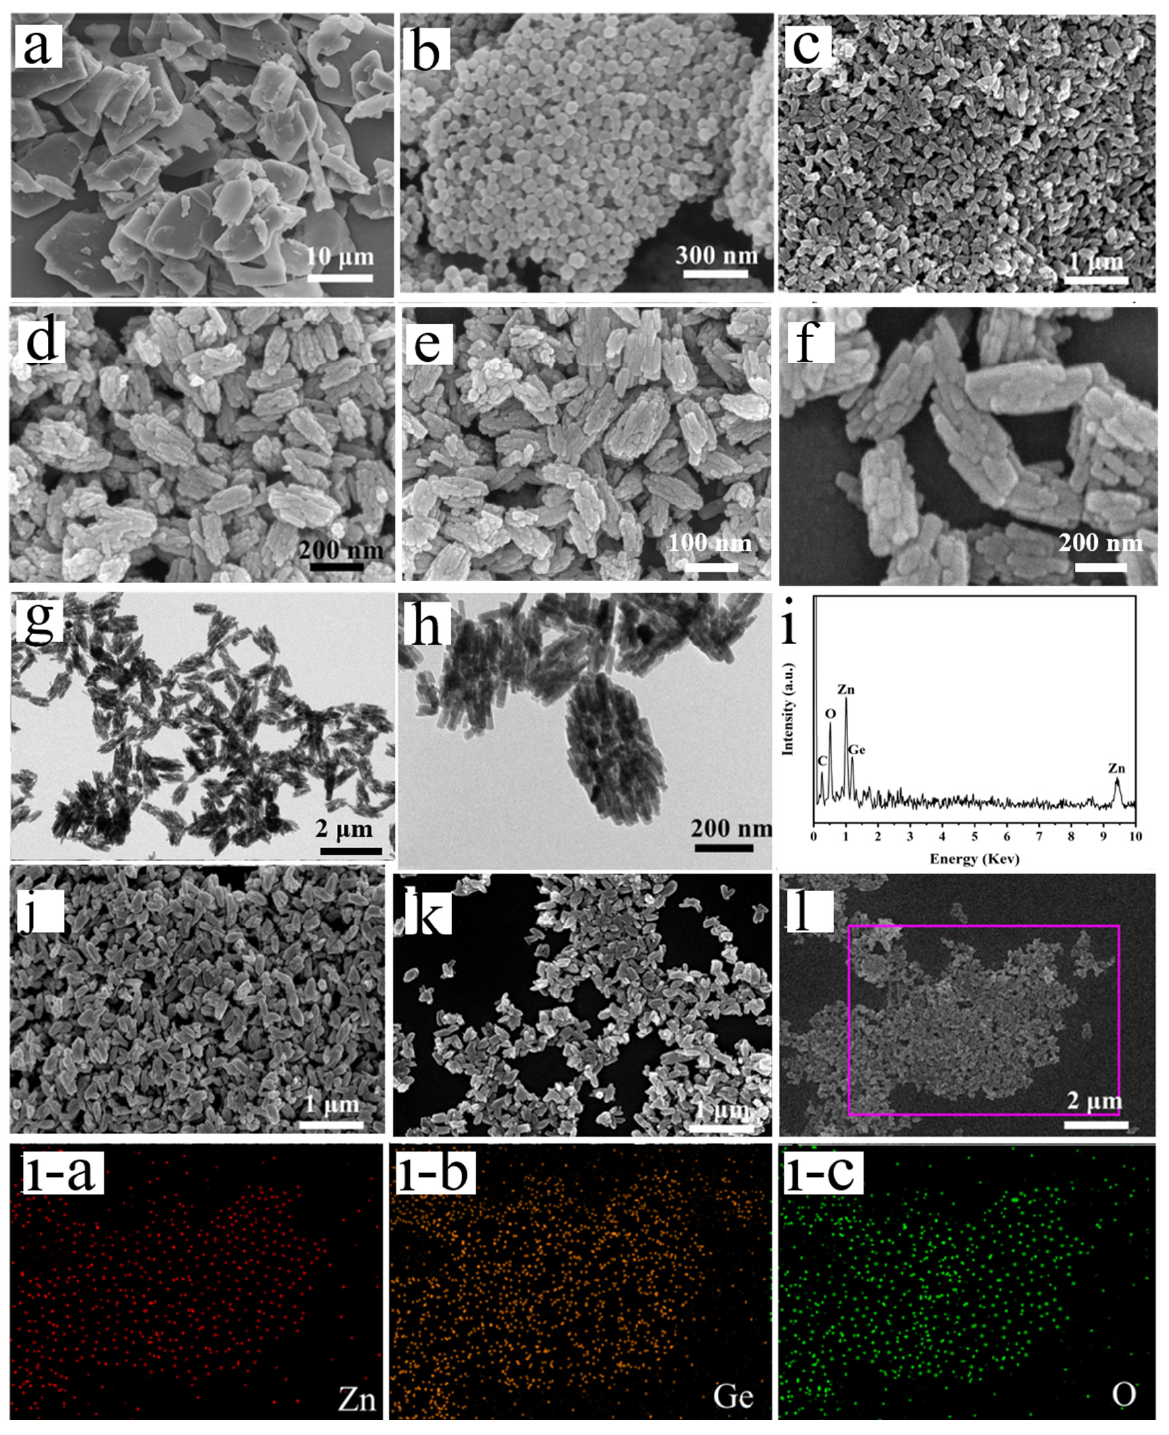
Figure 4. SEM images of ( a ) Ge-MOF, ( b ) Zn-MOF and ( c – f ) Zn 2 GeO 4 -150. ( g – h ) TEM image of Zn 2 GeO 4 -150 sample. ( i ) EDS pro fi le of Zn 2 GeO 4 -150. ( j ) SEM image of Zn 2 GeO 4 -130, ( k ) SEM image of Zn 2 GeO 4 -180, and ( l ) SEM image of Zn 2 GeO 4 -150 and the corresponding elemental mapping images of ( l-a ) Zn, ( l-b ) Ge and ( l-c ) O.